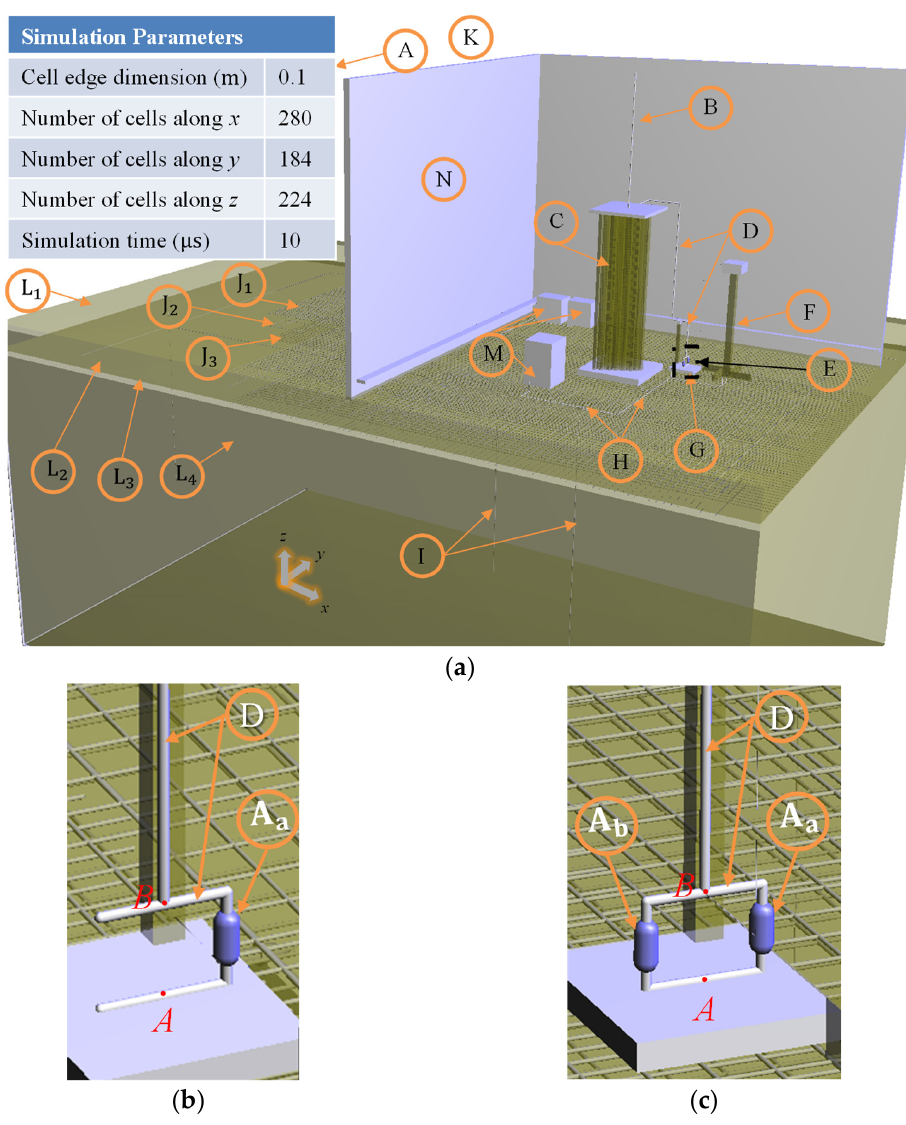
Figure 9. The conceived FDTD model: ( a ) simulation parameters and overview—A: table with simulation parameters, B: discharge current channel, C: lightning current generator, D: interconnection conductor, E: region of interest, F: voltage divider, G: metallic base for fixation of surge arrester, H: conductors for interconnecting parts to the grounding system, I: deep grounding rods, J 1 , J 2 and J 3 : grounding grids, K: air, L 1 : reinforced concrete in which J 1 is contained, L 2 : compacted soil containing grid J 2 , L 3 : reinforced concrete containing grounding grid J 3 , L 4 : soil, M: metallic blocks representing transformers in the test area, N: metallic wall; ( b ) detail of the region of interest of the typical configuration— A (cid:2911) : representation of the surge arrester; ( c ) region of interest for the proposed configuration— A (cid:2911) and A (cid:2912) : representation of two parallelly installed SAs. Notice that insulator voltage 𝑉 (cid:3002)(cid:3003) is obtained by line-integrating electric field between terminals A and B (indicated using red color). Table 1. Electromagnetic parameters of materials represented in FDTD model.